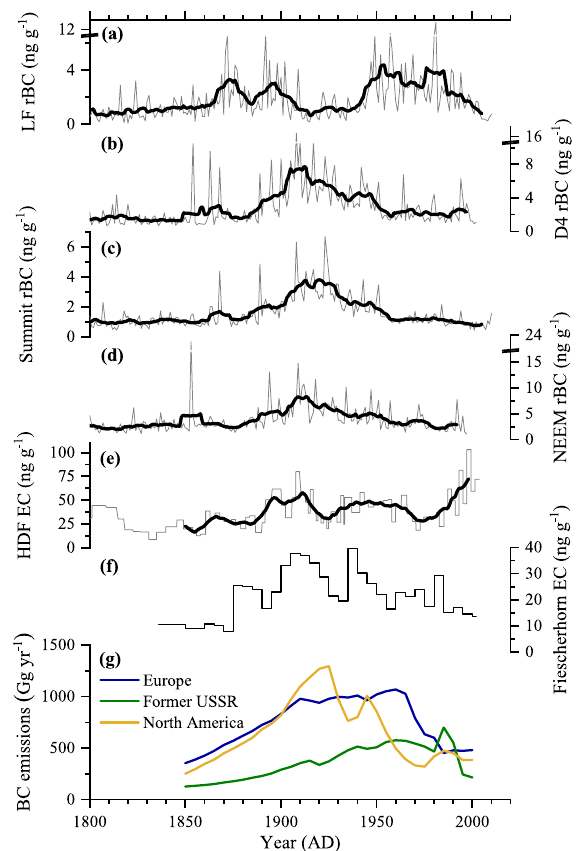
Figure 5. Comparison of (a) Lomonosovfonna rBC concentra- tions to other ice core records from 1800 on, namely rBC from (b) D4, Greenland (McConnell et al., 2007), (c) Summit 2010, Greenland (Keegan et al., 2014), and (d) NEEM 2011-S1 (Sigl et al., 2013), Greenland; (e) EC from Holtedahlfonna, Svalbard (Ruppel et al., 2014), and (f) Fiescherhorn, Swiss Alps (Gabbi et al., 2015; Jenk et al., 2006); and (g) BC emission inventories (5- year averages) for Europe, North America, and the former USSR (Bond et al., 2007). Europe represents the sum of OECD Europe and eastern Europe and North America the sum of Canada and the USA. Thin lines represent annual averages except for Holtedahl- fonna (raw data) and Fiescherhorn (5-year averages) due to lower resolution. Bold lines are 11-year moving averages (in the case of Holtedahlfonna, they are calculated from a 2-year resolution ap- proximately). Note the different y axis